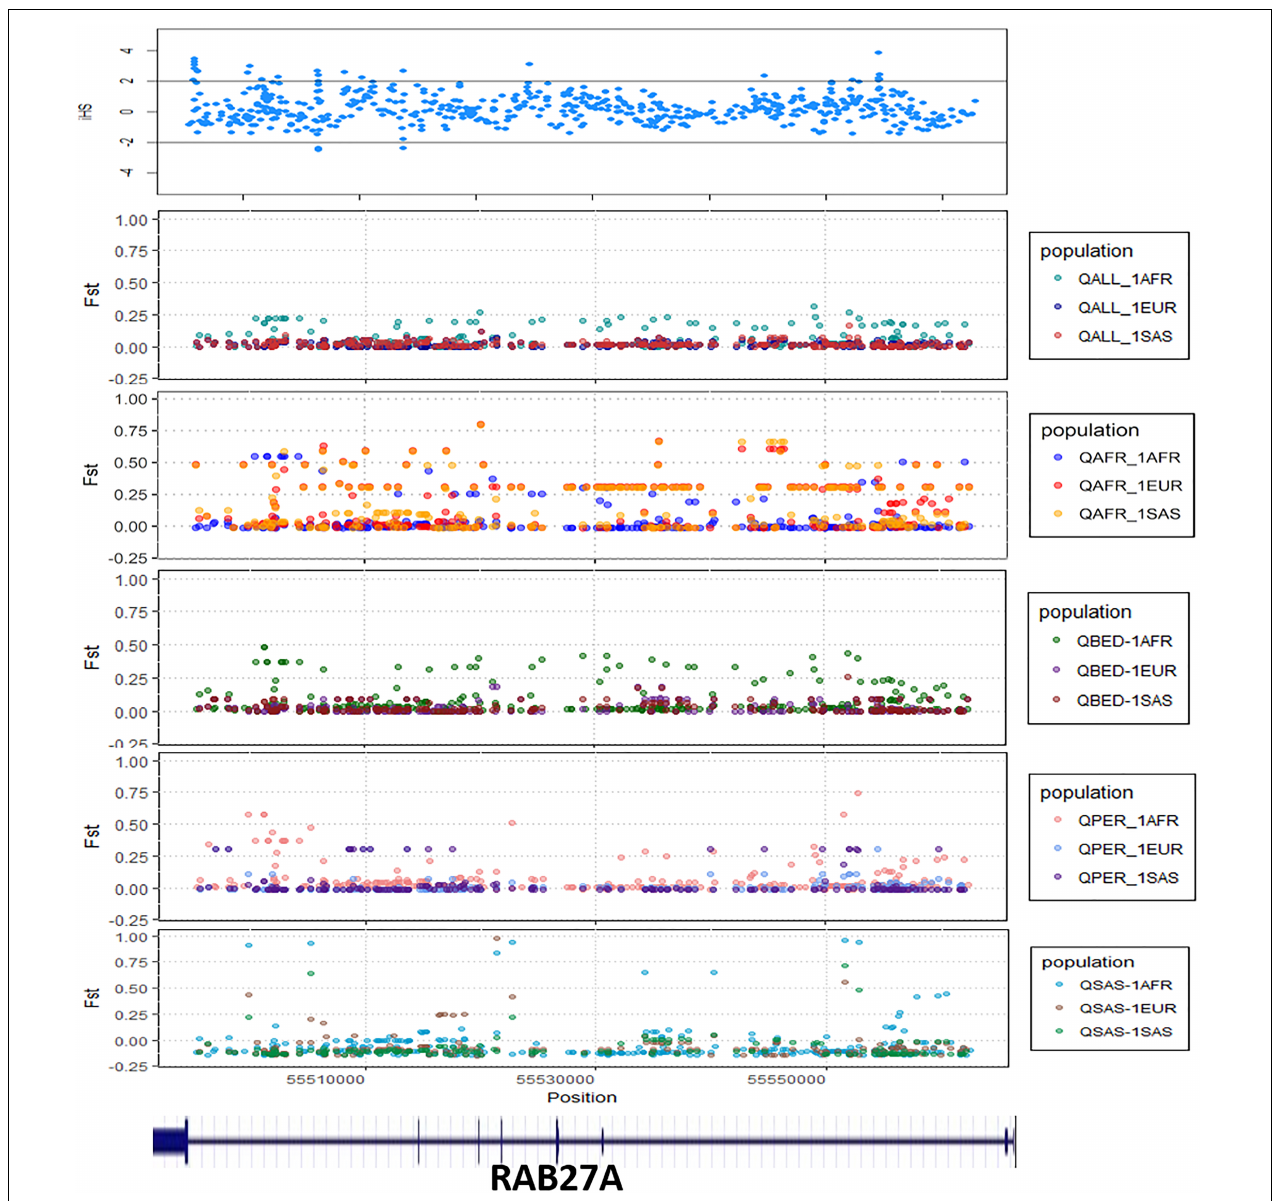
FIGURE 3 | The Fst and iHS score depicted for RAB27A gene from the Qatari population (QALL, Qatar 1005 dataset; 1AFR, 1000 Genome AFRICAN; 1EUR, 1000 Genome EUROPEAN; 1SAS, 1000 Genome South Asian; QPER, Qatar-Persian subset; QBED, Qatar-Bedouin subset; QARB, Qatar-Arab-subset; QAFR, Qatar-African-subset; QSAS,